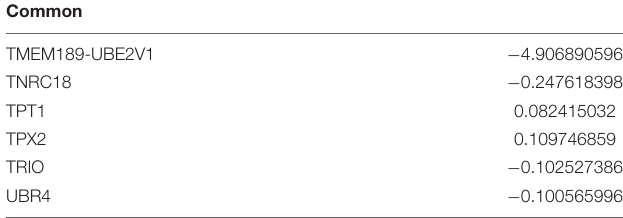
TABLE 1 | Common deregulated genes in SKOV3 and COV434 after radiation